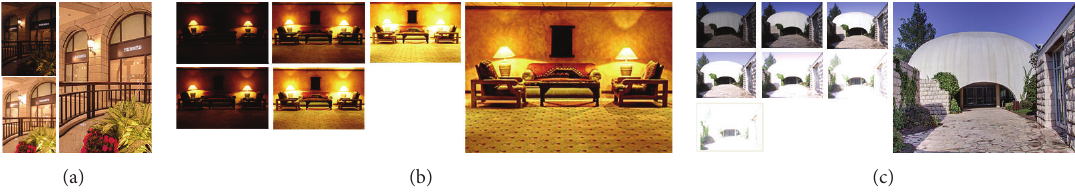
Figure 4: Our results for different multiexposure sequences. (a) Hermes (two input exposures), (b) Chairs (five exposures), and (c) Syn (seven input